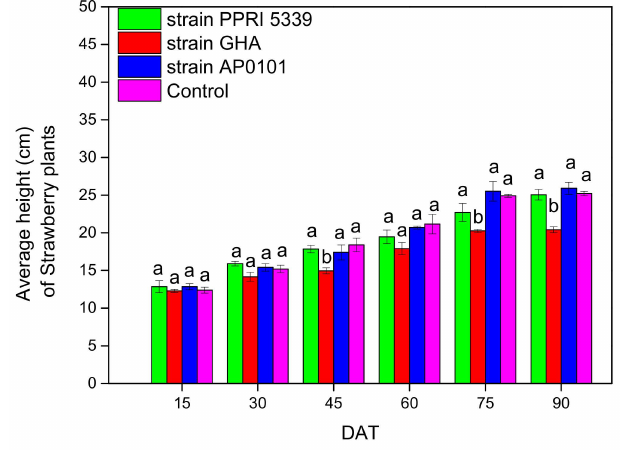
Figure 10. Average height (cm) of Fragaria sp. plants inoculated with B. bassiana. Each treated plant was watered with 10 mL of 10 8 conidia/mL suspension at the stage of four leaves (November 2021), and after 4 months (March 2022), means of the same DAT marked with the same letter did not differ significantly (Tukey-Kramer test, p < 0.05); DAT: days after treatment. The average number of fruits per plant after 120 days ranged from 2.4 ± 0.7( B. bassiana GHA) to 4.3 ± 0.4 ( B. bassiana AP0101) with insignificant differences (F = 6.365, df = 3, 123, p = 0.131). The same pattern was observed in the following measurement points (Figure 11).